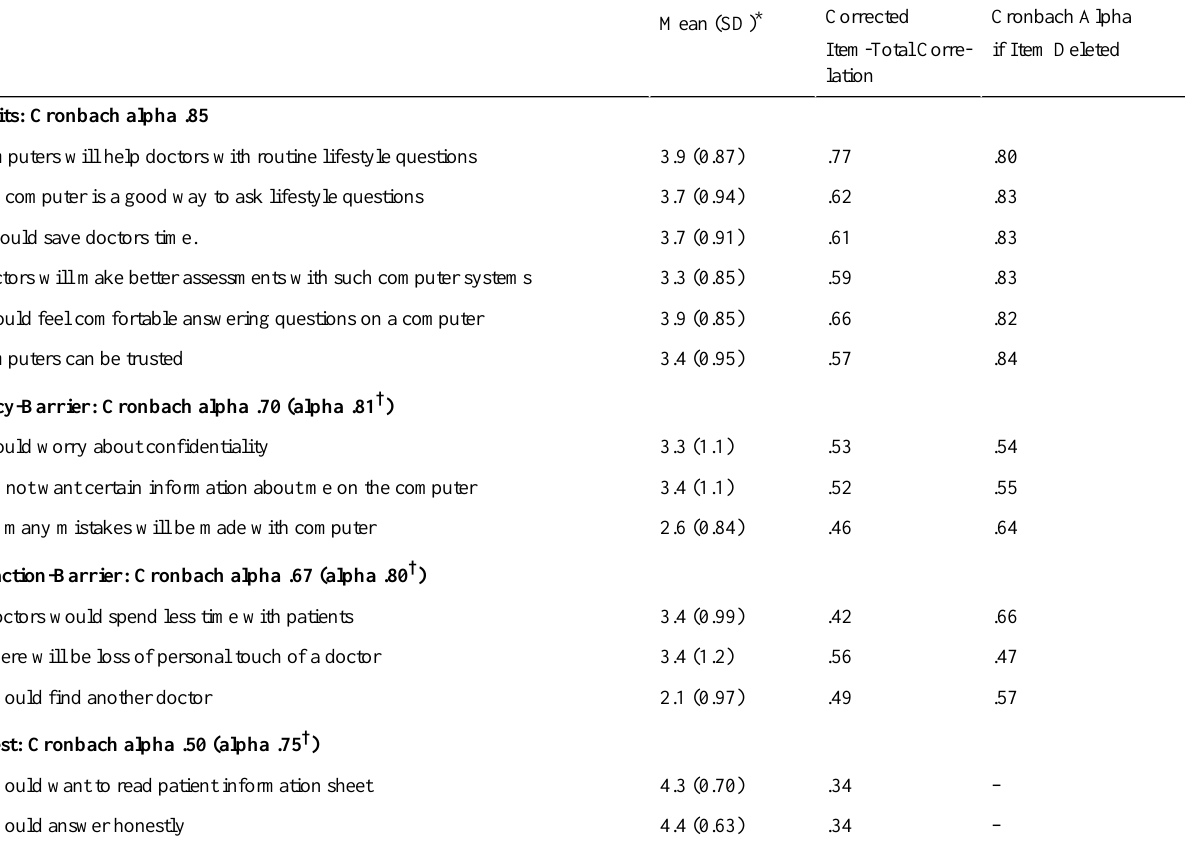
Table 4. Internal consistency of the subscales